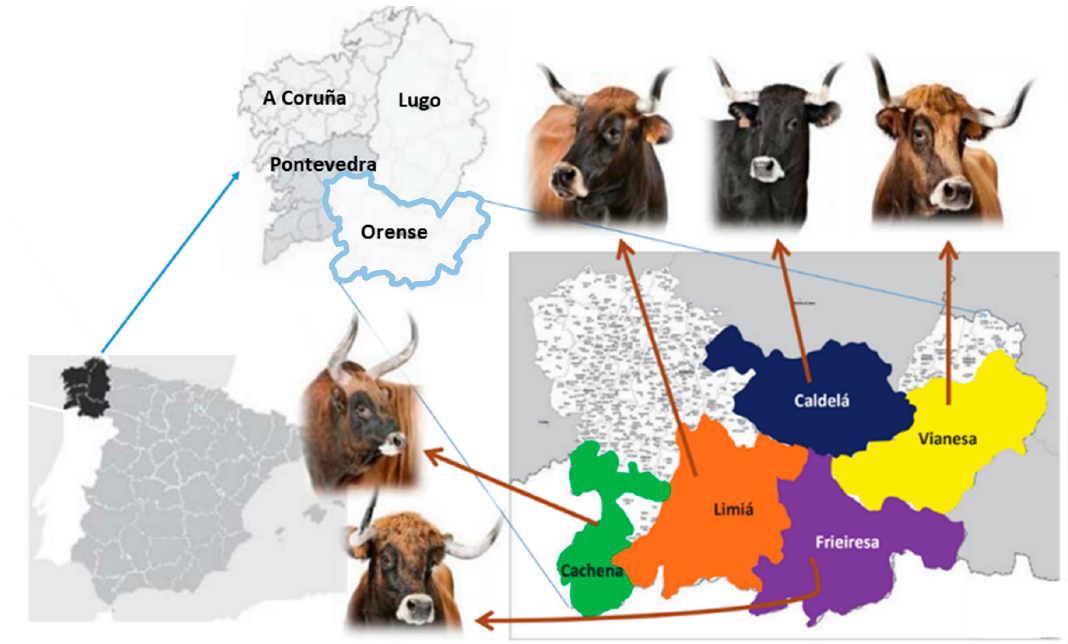
Figure 1. Geographic location of Morenas Gallegas bovine breeds: Cachena, Caldelá, Frieiresa, Limiá, and Vianesa. Table 1. Breeds names and number of samples analyzed per breed. Effective population size (Ne), observed and expected heterozygosity (H O and H E , respectively) and methods of moments inbreeding coefficient (F HOM ).